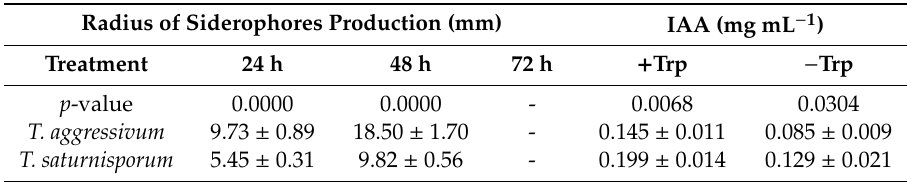
Table 2. Siderophores and IAA production by Trichoderma